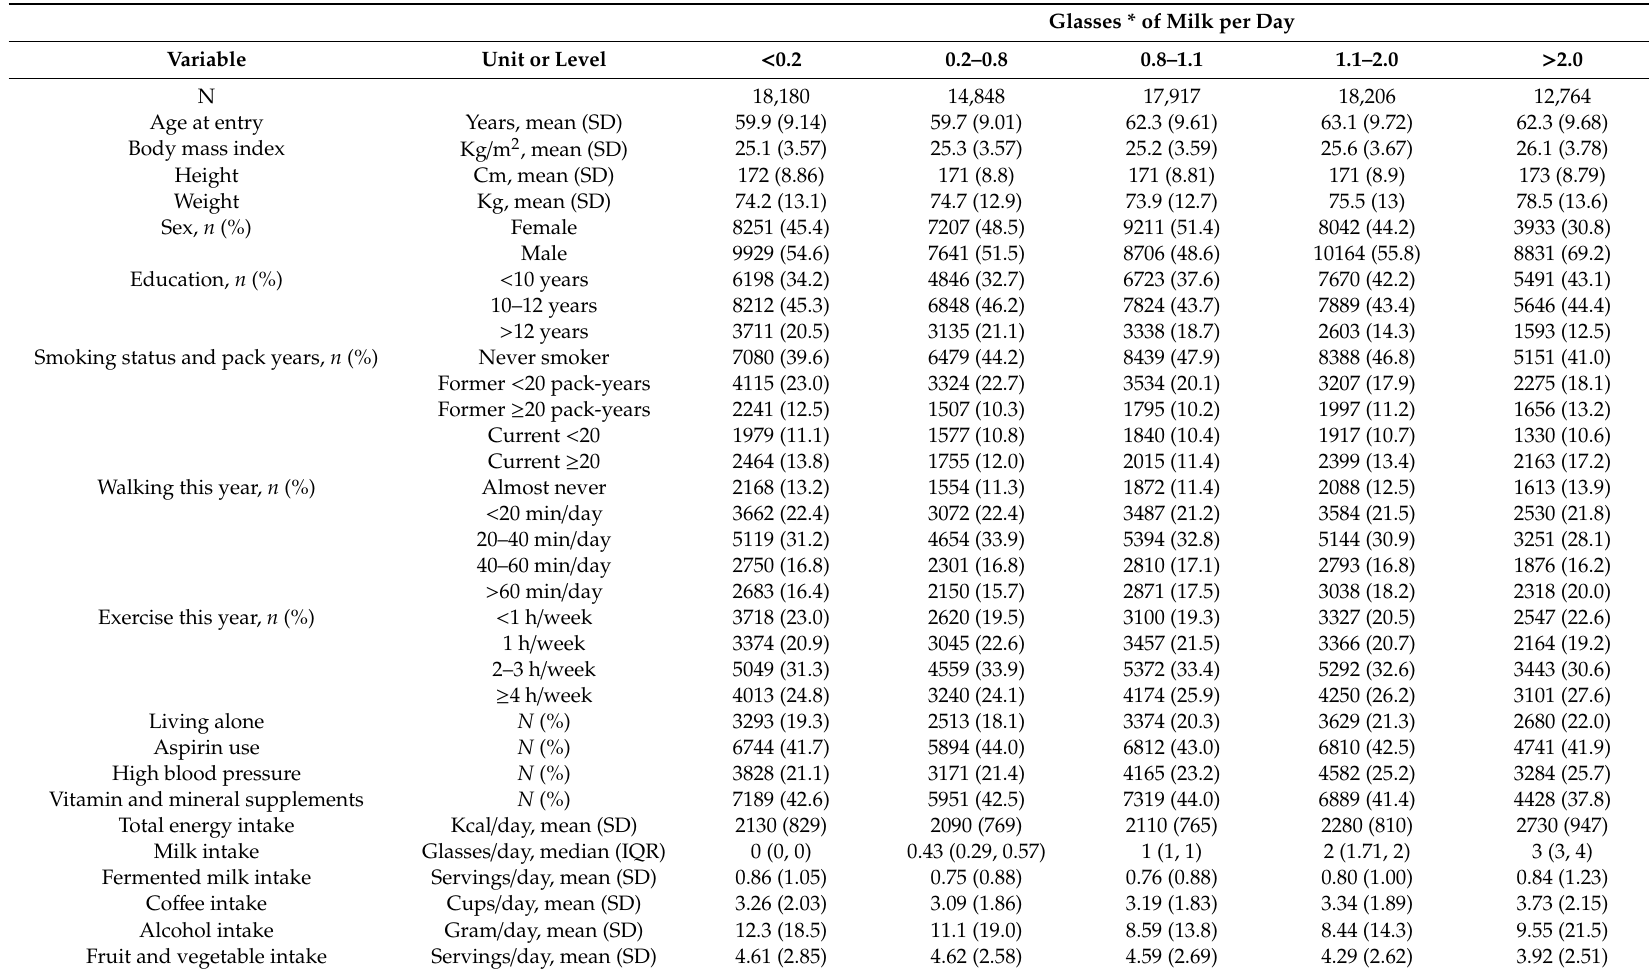
Table 1. Baseline characteristics of the whole study population (the Swedish Mammography Cohort and the Cohort of Swedish Men) by categories of glasses* of milk per